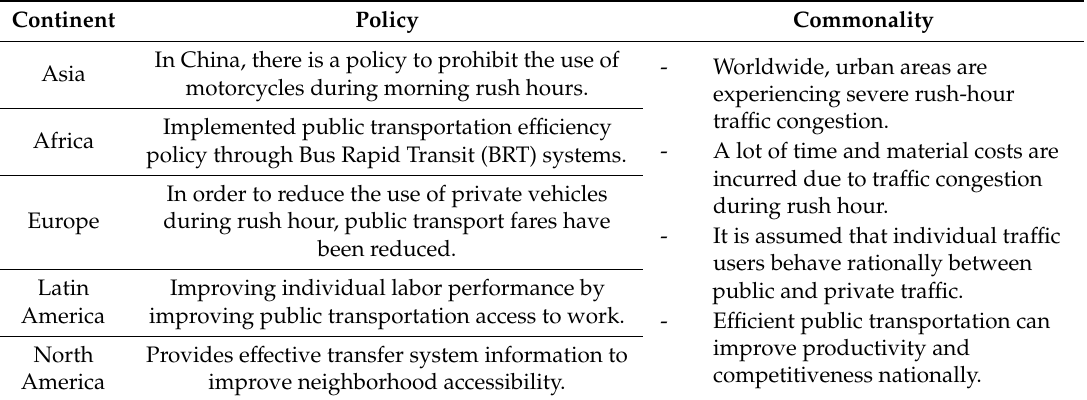
Table 4. Comparison of transportation system policies by